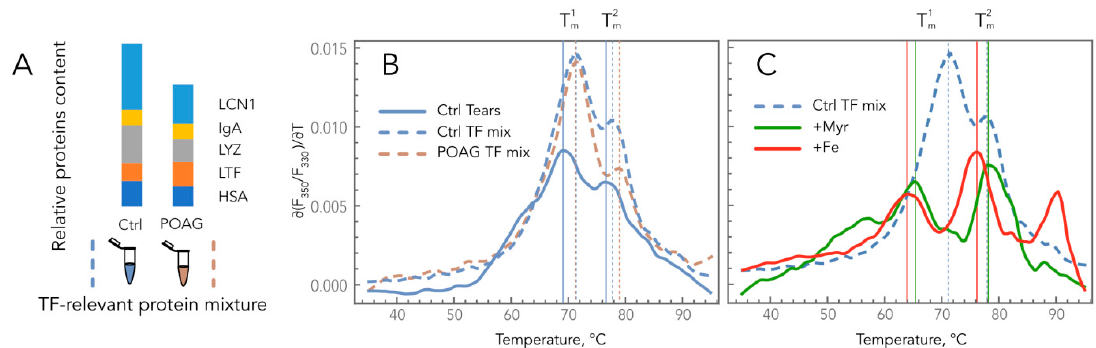
Figure 3. Impacts of the composition and ligand-binding states of the core tear proteins on TFDPs. ( A ) Schematic representation of control and POAG TF-relevant protein mixtures. ( B ) Comparison of denaturation profiles of control and POAG TF-relevant protein mixtures with those of normal TF. ( C ) Effects of myristic acid and iron on denaturation profiles of control TF-relevant protein mixture.